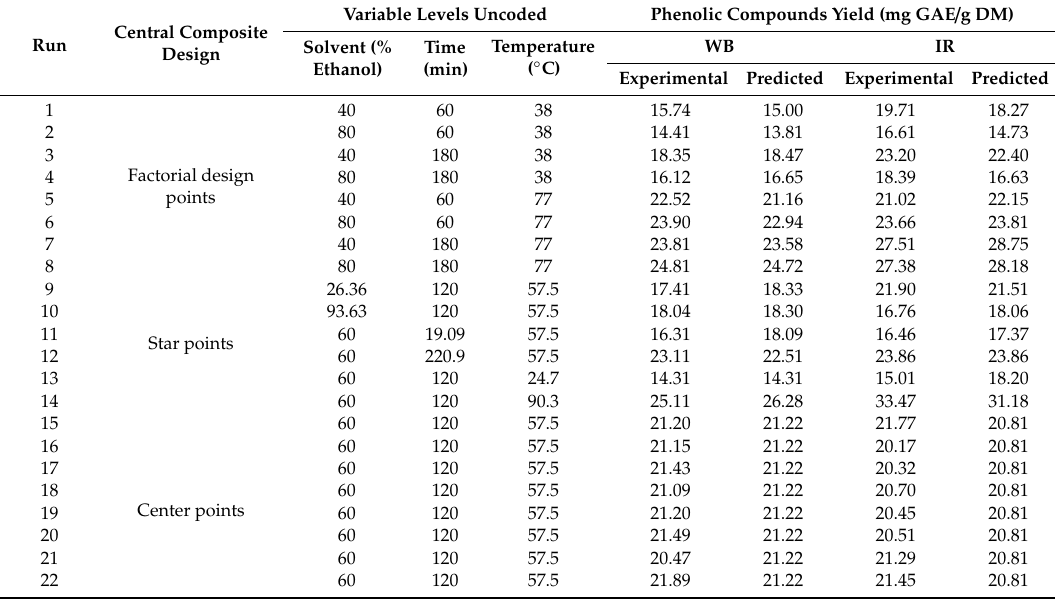
Table 2. Arrangement for independent variables and their responses for TPC (mg GAE / g dry matter (DM)). Variable Levels Uncoded Phenolic Compounds Yield (mg GAE / g DM) Central Composite Run WB IR Temperature Time Solvent (% Design ( ◦ C) (min) Ethanol) Experimental Predicted Experimental Predicted